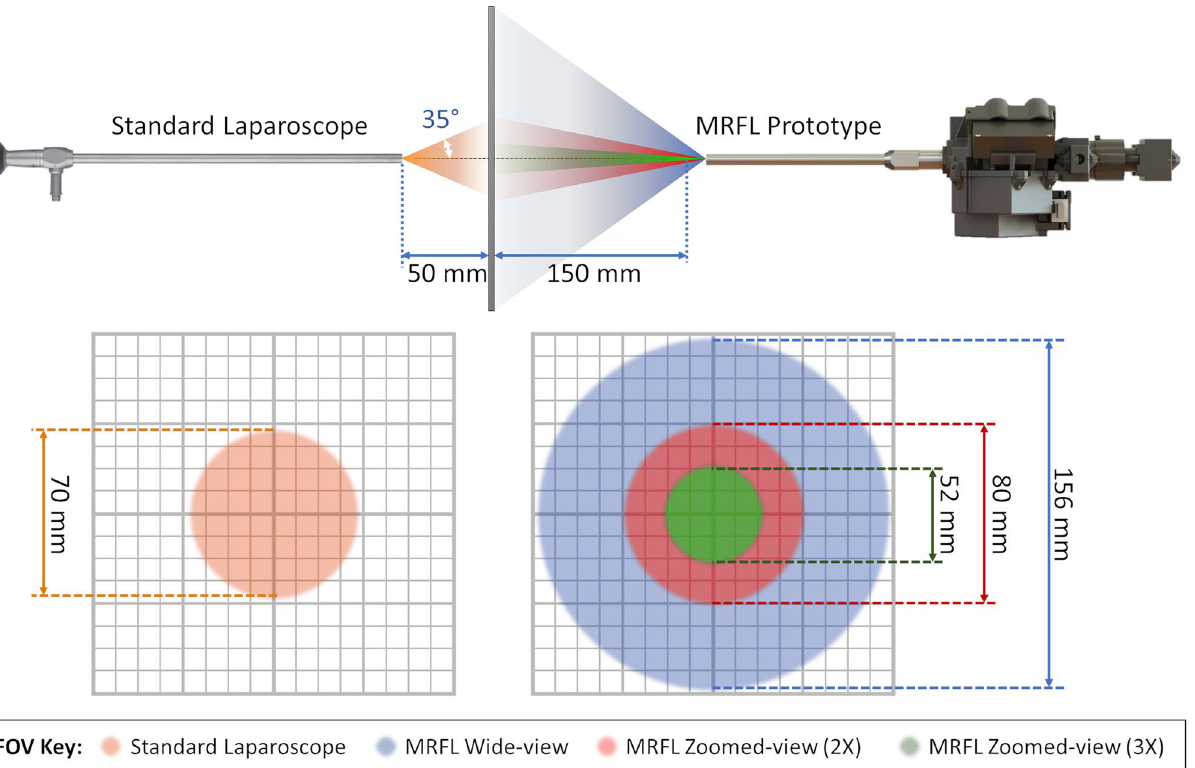
Figure 4. Diagram comparing the FOV and working distance of a standard laparoscope to that of the latest MRFL